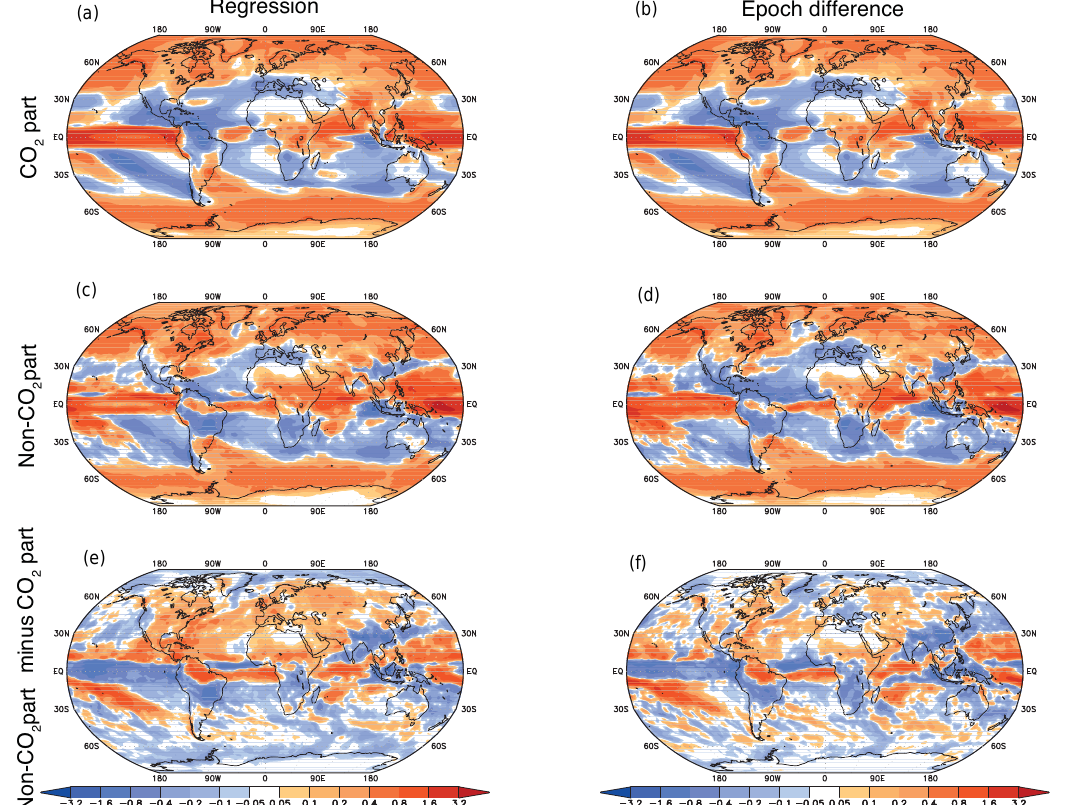
Figure 9. The CO 2 (a, b) and non-CO 2 (c, d) responses over years 227–251 (2076–2100) of the RCP8.5 simulation, as well as the dif- ference between the two (e, f) . CO 2 response is calculated as (cid:49) ˆ B = P 1pctCO2 (cid:49) ¯ T RCP8 . 5 (227–251), and non-CO 2 response is calculated as (cid:49) ˆ B = P non − CO (cid:49) ¯ T RCP8 . 5 (227–251) (see Eq. 1 and the discussion surrounding Eq. 6 for further details). Left column shows results for the 2 regression method and right column shows the epoch-difference